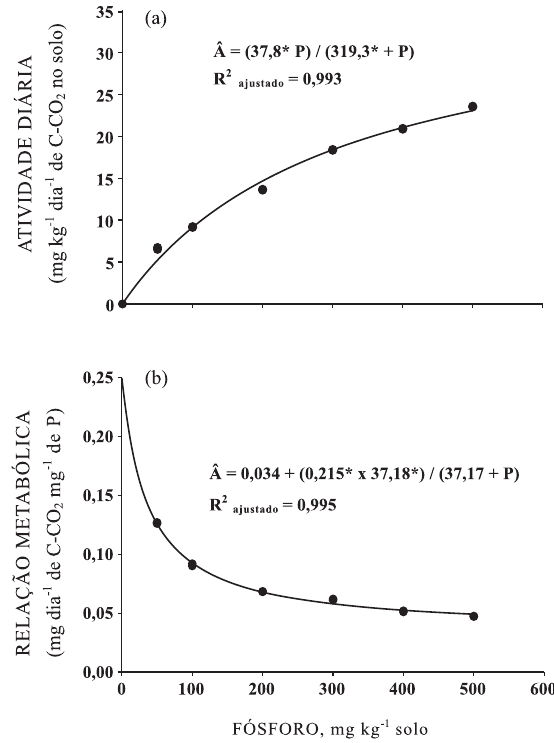
Figura 2. Equações de regressão da atividade metabólica em função da adição de fósforo no solo. (a) regressão do modelo Michaelis-Menten, entre respiração diária e adição de P. (b) regressão entre relação metabólica (taxa diária Figura 1. Liberação de CO do solo em resposta à 2 por fósforo adicionado) e adição de P. * adição de fósforo. As barras indicam os significativo a 1 intervalos de confiança a 5 % (n = 2).